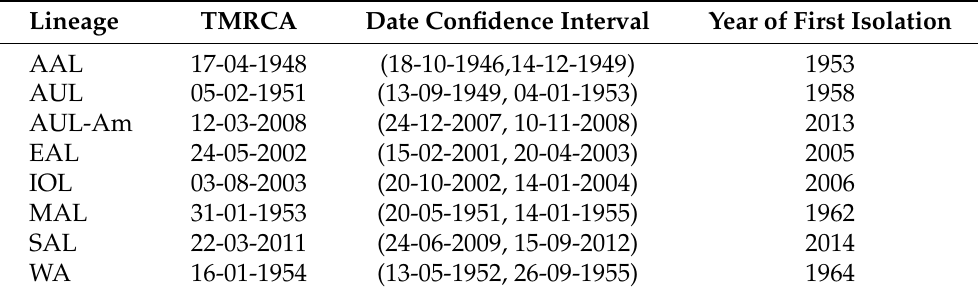
Table 2. TMRCA estimates of CHIKV lineages, extracted from the Nextstrain instance. Dates are formatted as